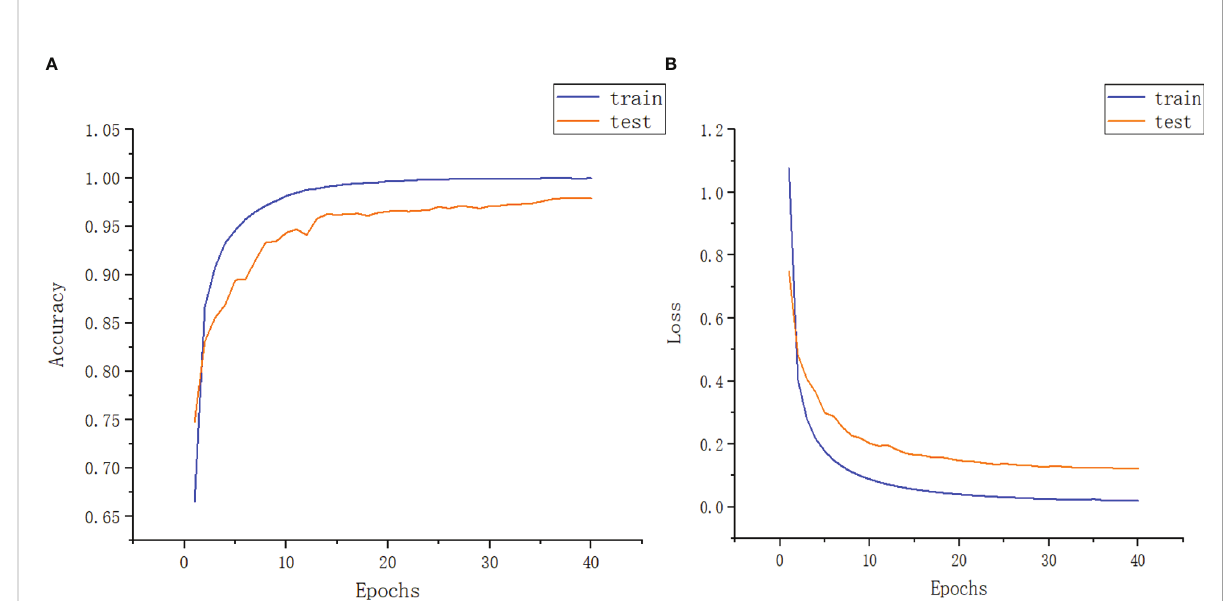
FIGURE 11 Function diagram of experimental accuracy and experimental loss rate. (A) Image model accuracy (B) Model loss rate